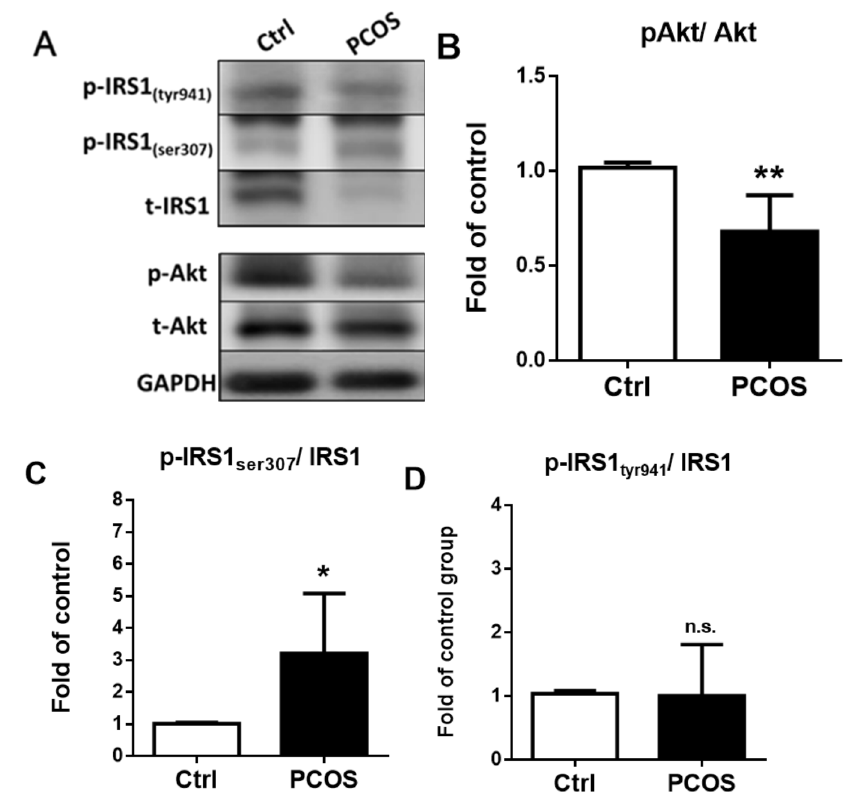
Figure 10. The insulin signal transduction pathway analysis of the perigonadal white adipose tissue (pgWAT) was performed in the letrozole-treated and control mice using Western blotting ( A ). Quantification analysis of relative Akt ( B ), IRS-1-Ser307 ( C ), and IRS-1-Tyr941 ( D ) phosphorylation in the pgWAT. Results are expressed as the mean ± SD. n.s.: not significant; * p < 0.05; ** p < 0.01, compared with the control mice.